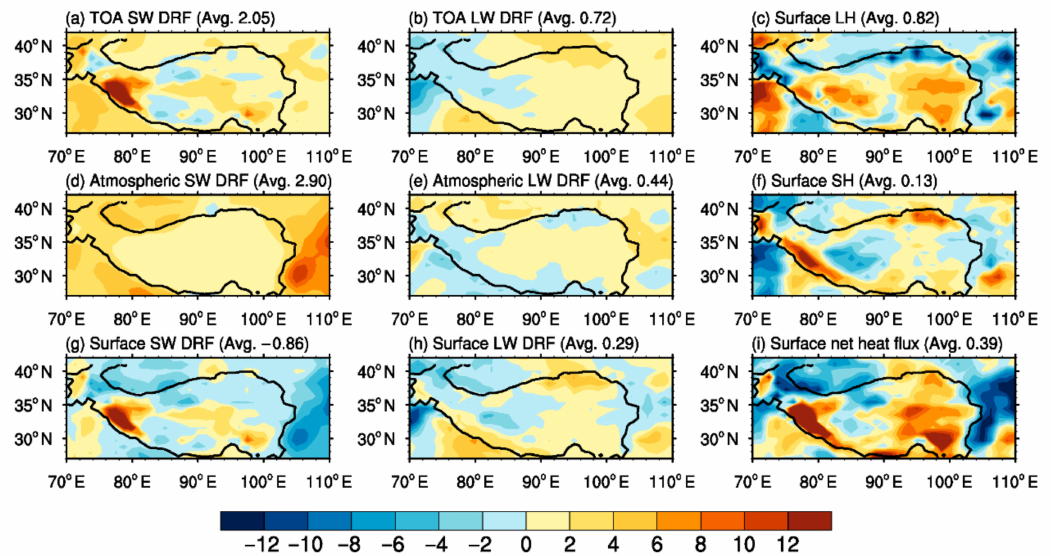
Figure 5. Shortwave and longwave direct radiative forcing (DRF) (W / m 2 ) at the top of atmosphere (TOA) ( a , b ), in the atmosphere ( d , e ) and on the surface ( g , h ), latent heat flux ( c ), sensible heat flux ( f ) and the net heat flux ( i ) during the summer for period from 2001–2005. The area of the TP is enclosed by a black line. the down direction is defined as the positive value, otherwise the upward direction is defined as the negative